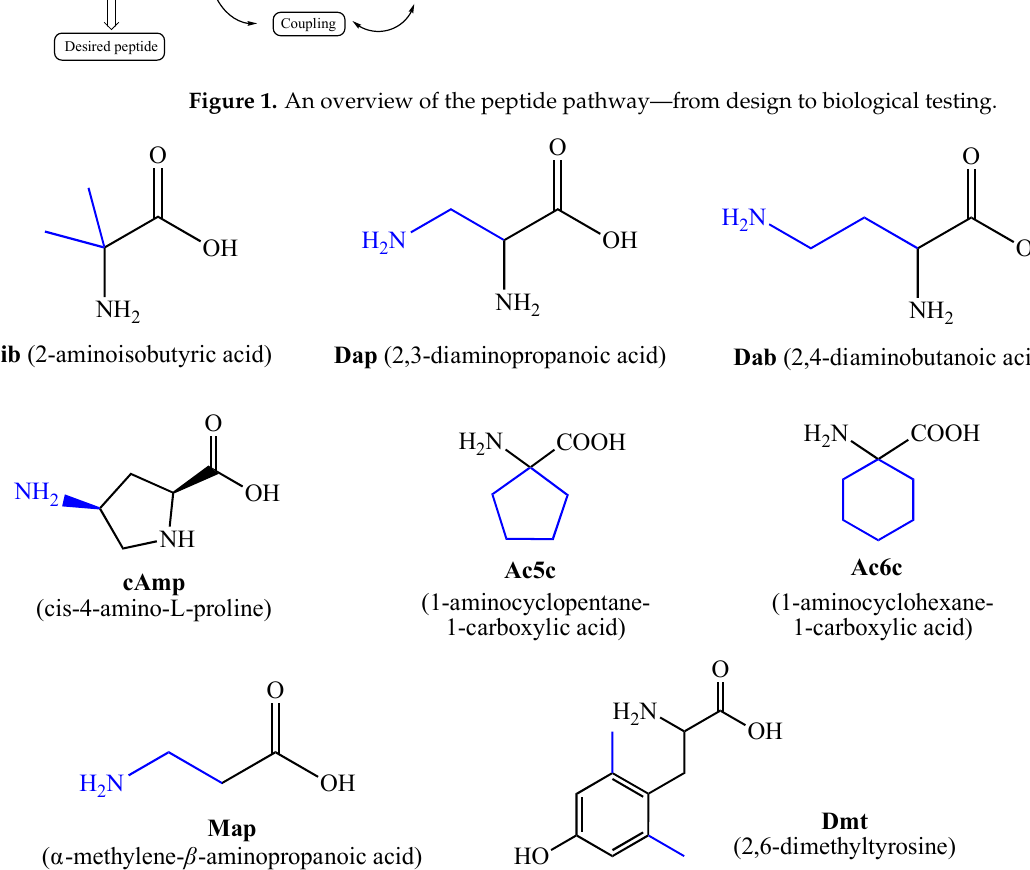
Figure 1. An overview of the peptide pathway—from design to biological testing. Changes occurring in the amino acid scaffold can lead to the preparation of new bi- ologically active molecules with potential application in drug design and medicinal chem- istry [20,32,38–40]. Some of the most usually used non-natural and non-proteinogenic amino acids that are introduced into peptide chains are shown in Figure 2: